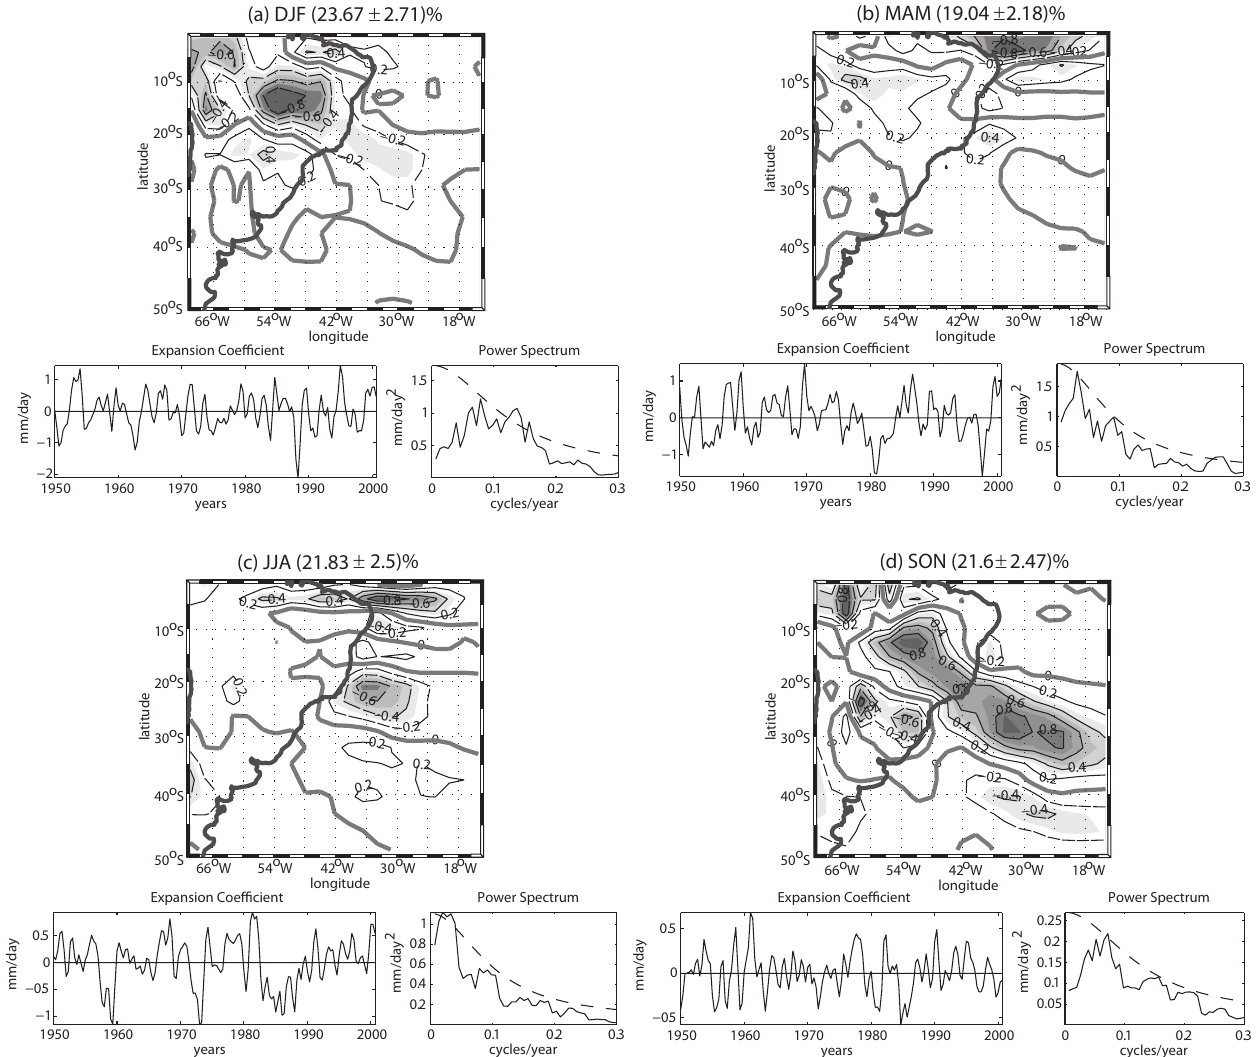
Fig. 9. First mode of REOF for simulated precipitation from EXP2 without the ENSO signal. Shaded areas represent eigenvector magnitudes higher than | 0.3 | . Time series of expansion coefficients (mmday − 1 ) and the associated power spectrum are located in the panel below. The power spectrum is calculated via multitaper method. Frequencies above the dashed line are significant at the 95% level relative to a red noise background spectrum. (a) DJF, (b) MAM, (c) JJA and (d)